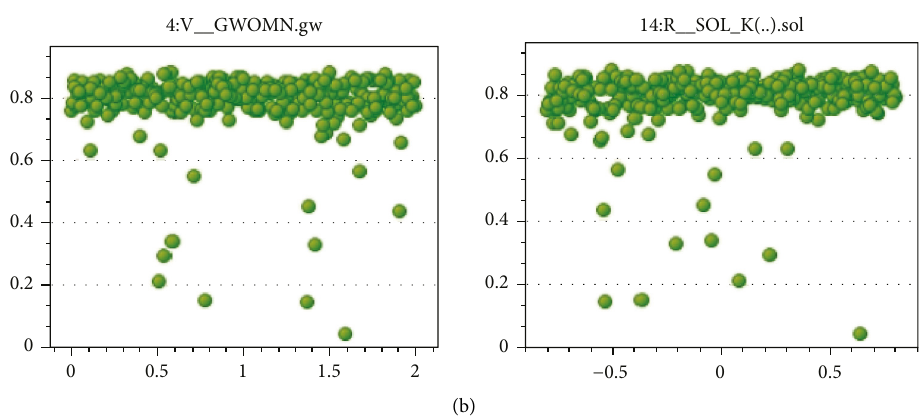
Figure 8: Monthly dotty plots of the most sensitive parameters of the Nashe watershed.